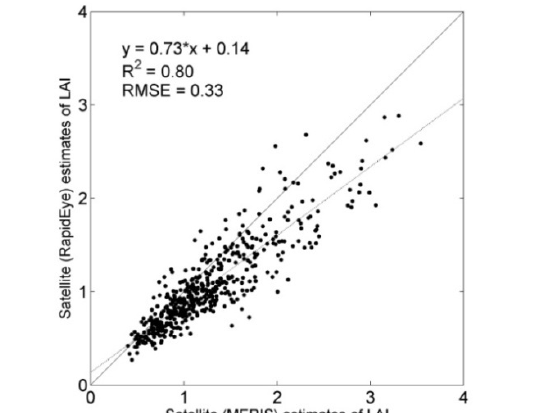
Figure 7. Comparison between MERIS LAI (derived using the TOC-VEG processor, BEAM VISAT) and LAI estimated from RapidEye satellite sensor data aggregated at 1 km spatial resolution.